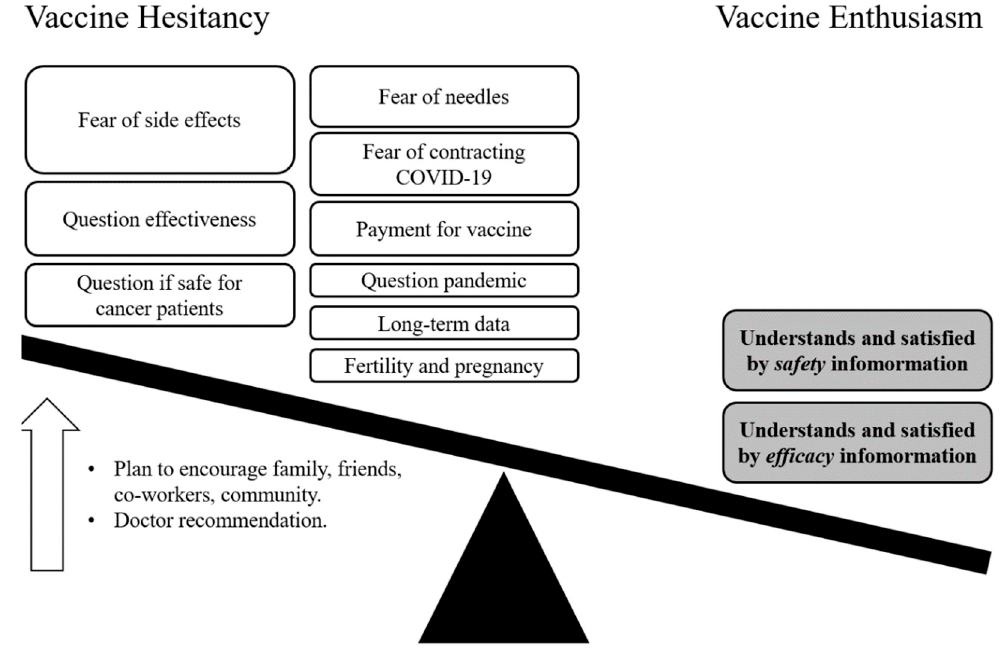
Figure 6. Model of vaccine hesitancy or enthusiasm in cancer patients. The size of the boxes is proportionate to their frequency in the cancer population participating in a webinar on vaccines and COVID-19. The gray boxes indicate the association between factors and the plan to receive a vaccine. The factors next to the up-arrow are associated with decreasing vaccine hesitancy in the cancer population participating in a webinar.